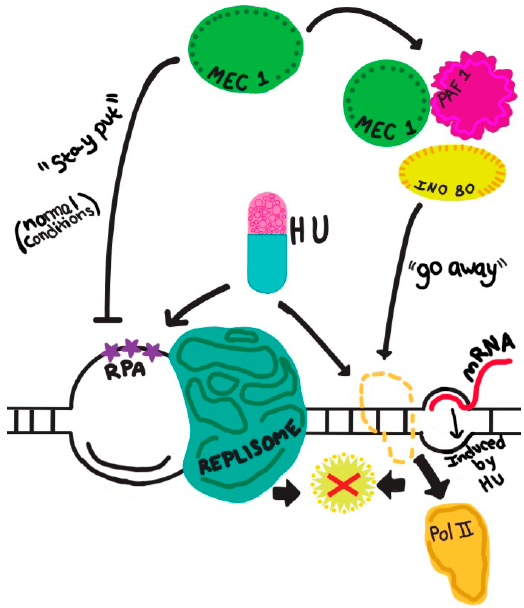
Figure 2. Schematic representation of converging replication and transcription, endangering the chromosome template for DNA double strand breaks (depicted by a red cross). The dual effects of a replication inhibitor, (e.g., hydroxyurea, HU) simultaneously impacting replication and transcription (shown by two arrows descending from “HU”) are described in the main text. The precise function of Mec1 in the protection of a stressed (e.g., by HU) fork is yet to be defined, and is depicted as a “stay put” signal, which likely also operates during a normal S phase. The inhibitory nature of the signal is sheer speculation at present. The active removal of RNA Pol II by the Mec1 ‐ Ino80 ‐ Paf1 complex during replication–transcription conflict is featured here. Other novel protein complexes involving Mec1 await future discoveries. RPA: replication protein A, the ssDNA ‐ binding protein.